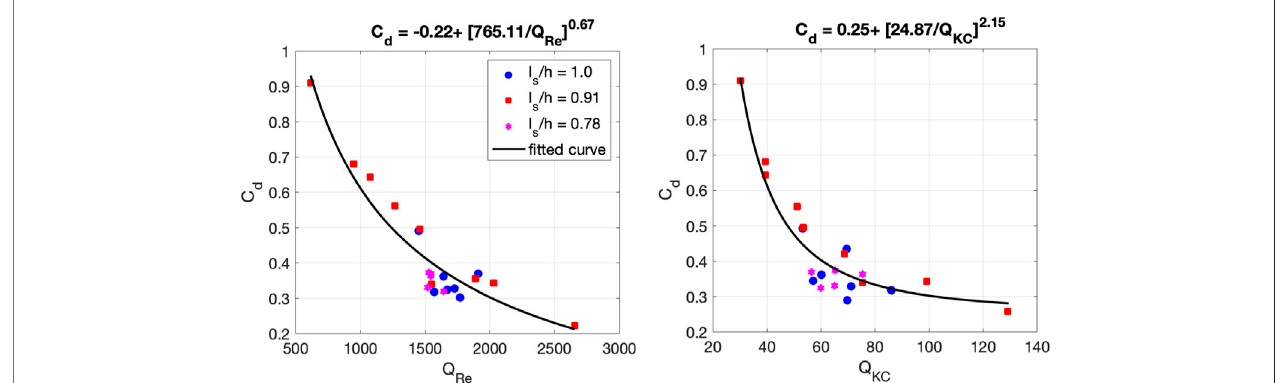
FIGURE2| Bulkdragcoef fi cient C d asafunctionof(left)modi fi edstemReynoldsnumber Q Re and(right)modi fi edKeulegan – Carpenternumber Q KC accountingfor stem submergence ratio for Anderson and Smith (2014) dataset. Different symbols represent different values of l s / h .